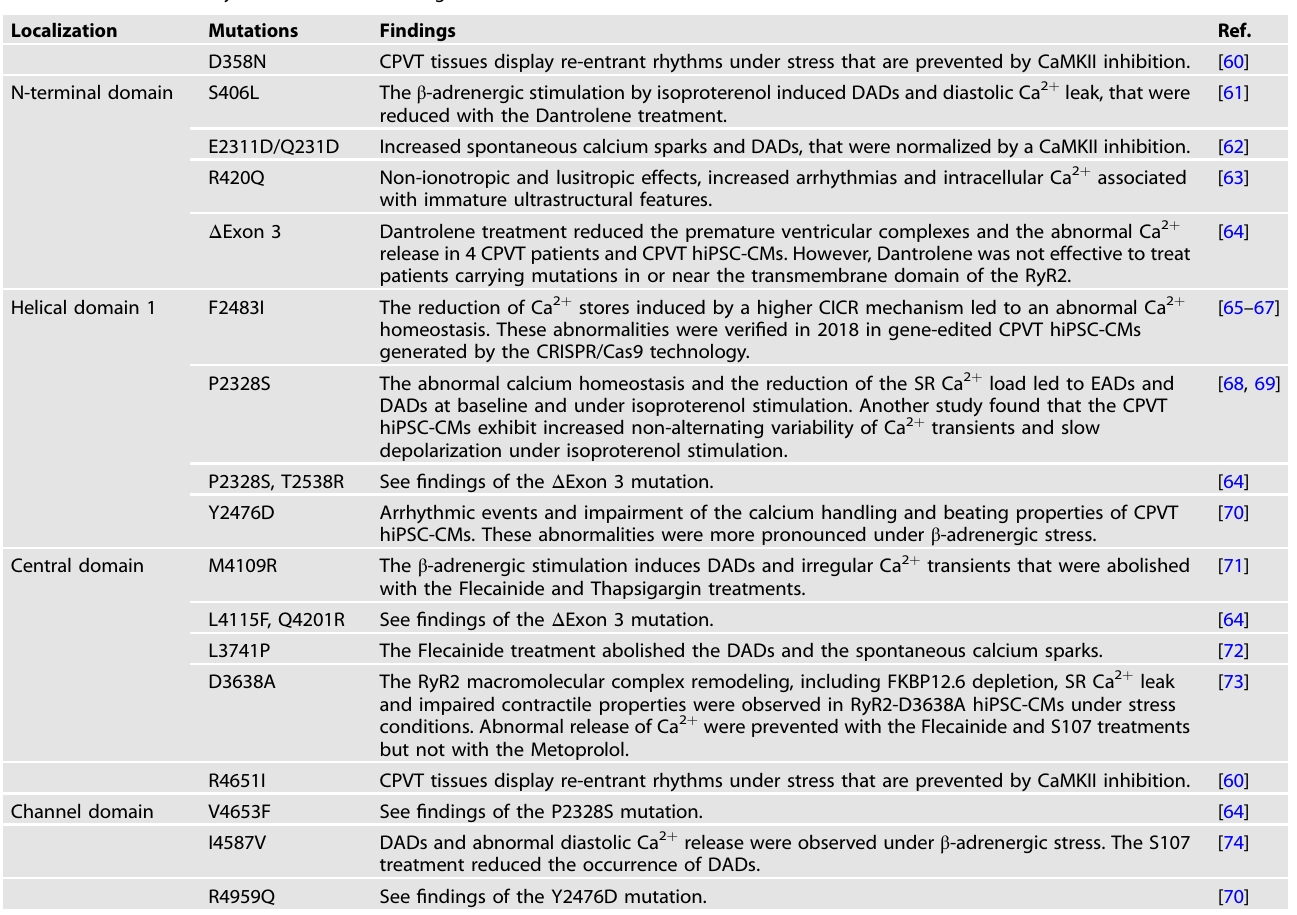
Table 2. List of CPVT1 syndromes modeled using the